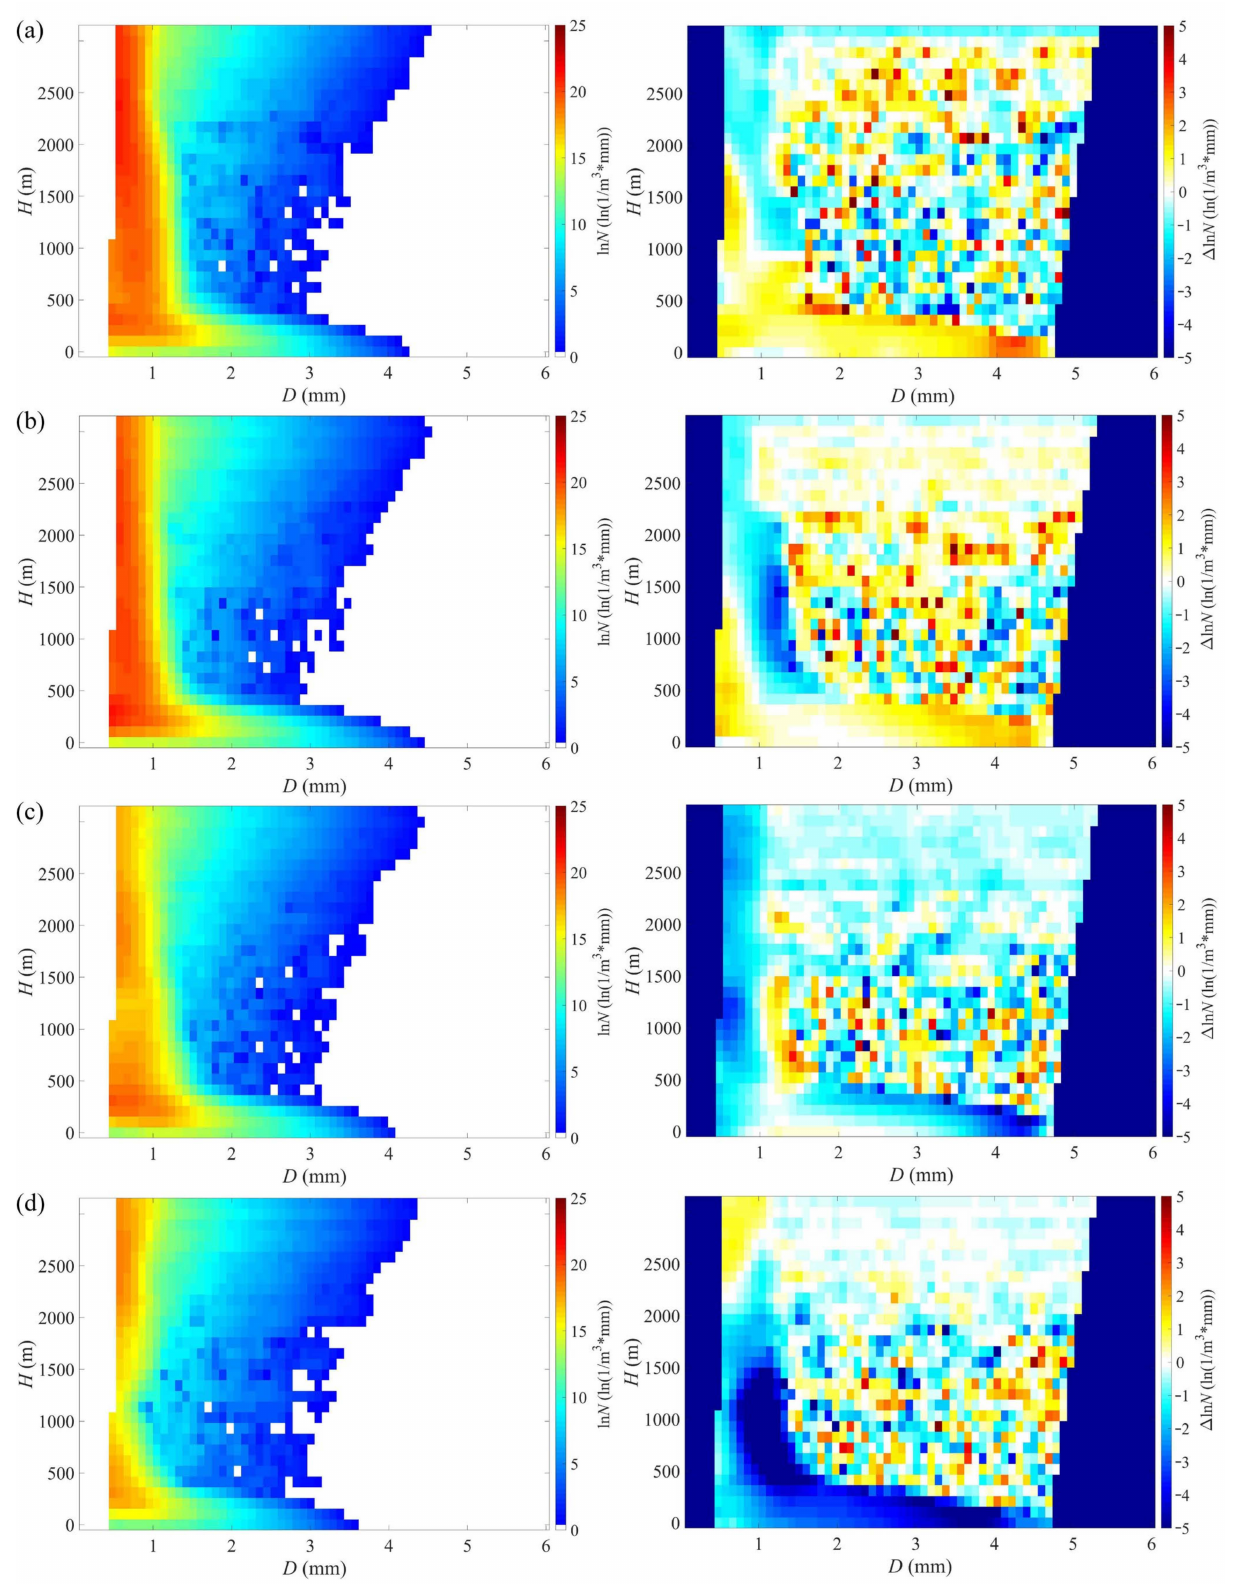
Figure 9. Temporal evolution of raindrop concentrations and the corresponding variations measured by MRR in the zenith direction of the field site. ( a ) t 1 = 6:40–7:00, ( b ) t 2 = 7:00–7:20, ( c ) t 3 = 7:20–7:40, ( d ) t 4 =